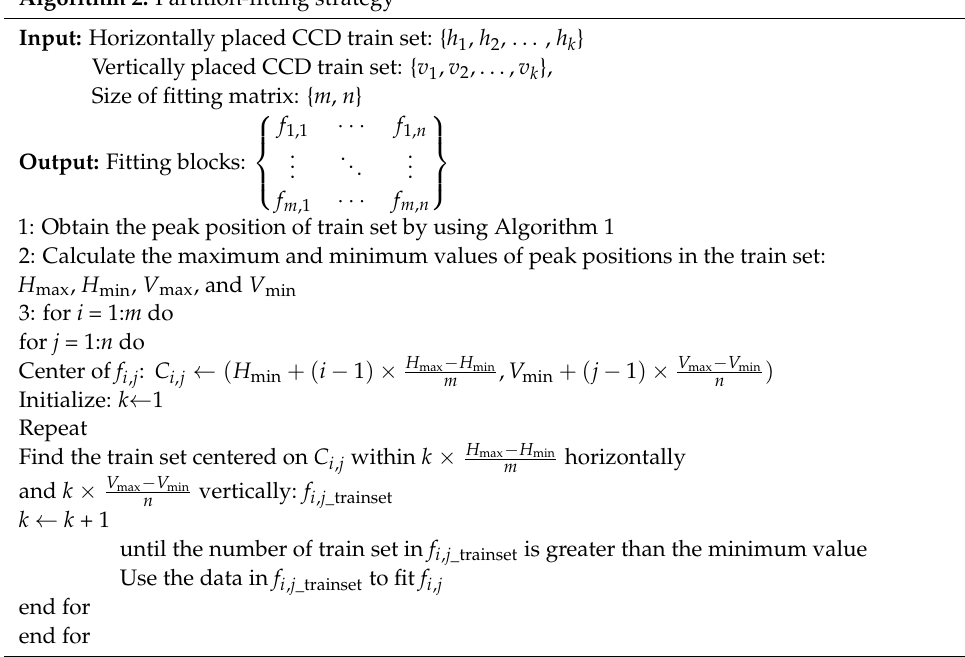
Algorithm 2. Partition-fitting